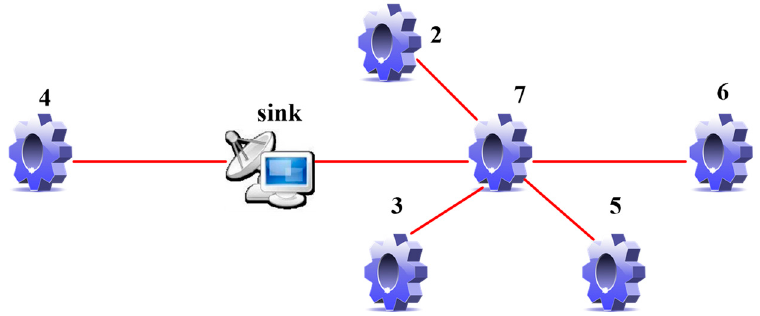
Figure 6. A topology of six wireless sensor network (WSN) sensor nodes.